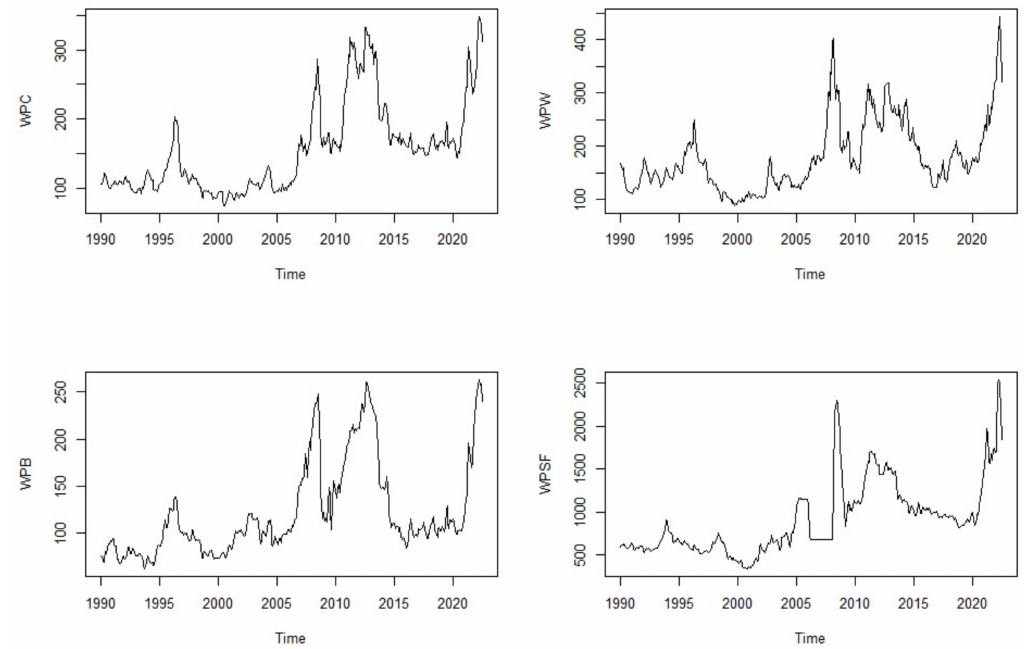
Figure 1. Market prices of WPC, WPW, WPB and WPSF from 1 January 1990 to 1 July 2022. Note: plots are constructed based on 391 observations and stand on monthly